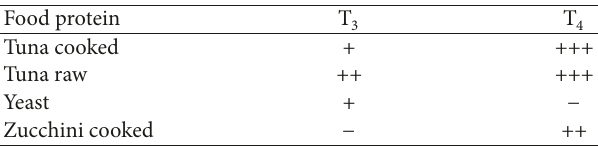
Table 2: Immunoreactivity of monoclonal antibodies to T3 and T4 with food proteins. Food protein T 3 T 4 Almond − Almond roasted